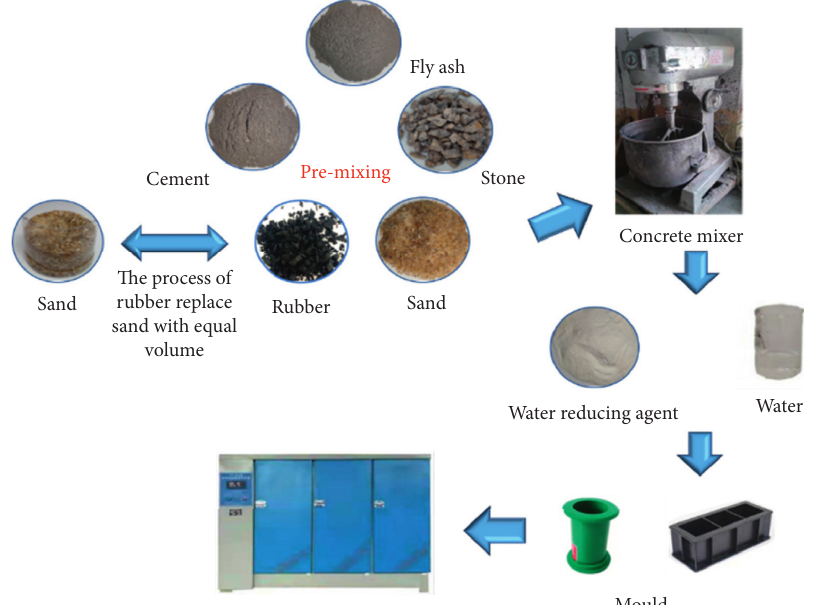
Figure 2: The production process for rubber concrete.